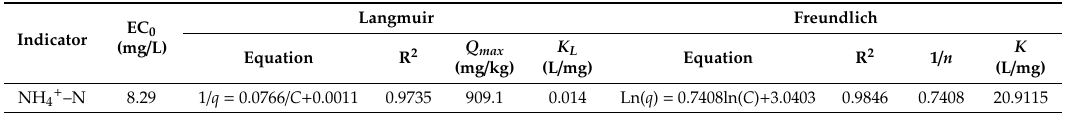
Table 1. Parameters of the fitting equations about NH 4 + –N adsorption and release characteristics in sediments of Biliuhe reservoir. EC, equilibrium concentration. Langmuir Freundlich EC 0 Indicator (mg / L)